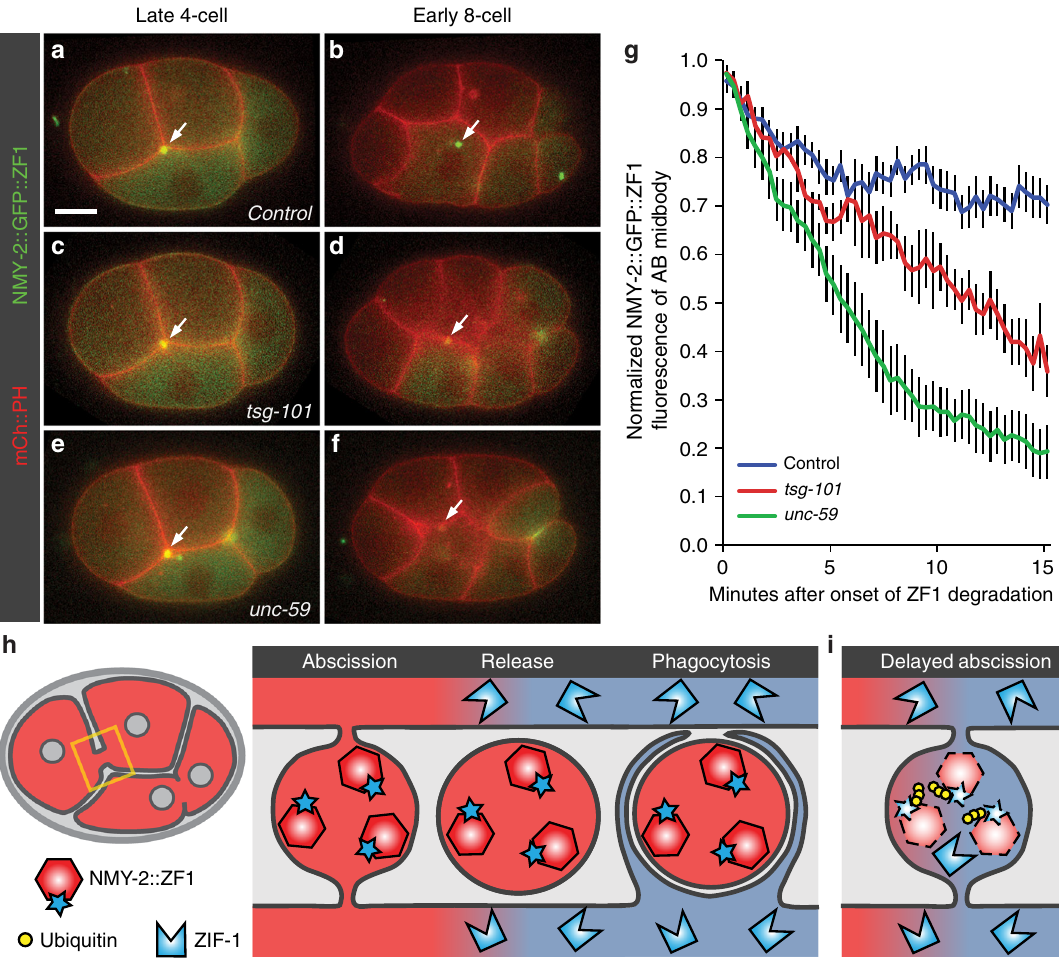
Fig. 9 Degron reporters reveal membrane topology during abscission. a – f Time-lapse images of embryos expressing mCh::PH to label the plasma membrane and NMY-2::GFP::ZF1 to label non-muscle myosin in the cytokinetic ring. Scale bar: 10 µ m. a In a control embryo, NMY-2::GFP::ZF1 between the anterior daughter cells (arrow) is protected from ZF1-mediated degradation due to its release outside cells in the midbody remnant after abscission. b NMY-2::GFP::ZF1 in the phagocytosed midbody remnant is protected from proteasomal degradation by engul fi ng membranes ( n = 19). c In embryos depleted of the ESCRT-I subunit TSG-101, NMY-2::GFP::ZF1 localizes to the intercellular bridge normally. d NMY-2::GFP::ZF1 is degraded after tsg-101 knockdown, indicating that abscission is incomplete and NMY-2::GFP::ZF1 is accessible to the degradation machinery. Engulfment of the AB midbody is also delayed, likely due to incomplete abscission ( n = 7). e , f Embryos depleted of the septin UNC-59 show rapid degradation of NMY-2::GFP::ZF1 from the intercellular bridge and delayed engulfment of the midbody remnant due to defects in abscission ( n = 8). g Fluorescence intensity of the NMY-2::GFP::ZF1 reporter on the intercellular bridge between anterior daughter cells (AB midbody) drops signi fi cantly for 2 min after the onset of ZF1 degradation in the cytoplasm of control embryos (blue, n = 11, p < 0.05 using Student ’ s t -test with Bonferroni correction), showing that NMY-2 is able to diffuse out of the bridge. Fluorescence then persists, showing that formation of a diffusion barrier, symmetric abscission, and engulfment protect the degron-tagged reporter from degradation. In contrast, NMY-2::GFP::ZF1 fl uorescence continues to drop in tsg-101 RNAi-treated embryos (red, n = 5, p < 0.05 compared to control after 8 min) and unc-59 mutants (green, n = 6, p < 0.05 compared to control after 3.5 min), showing that the ZF1 degron technique is sensitive to detecting small defects in abscission. Bars represent mean ± s.e.m. Source data are provided as a Source Data fi le. h In control embryos, degron reporters in the intercellular bridge are protected from proteasomal degradation due to release after abscission and encapsulation in a phagosome. i In abscission mutants, degron reporters are accessible to the cytosol, leading to their removal by proteasomal